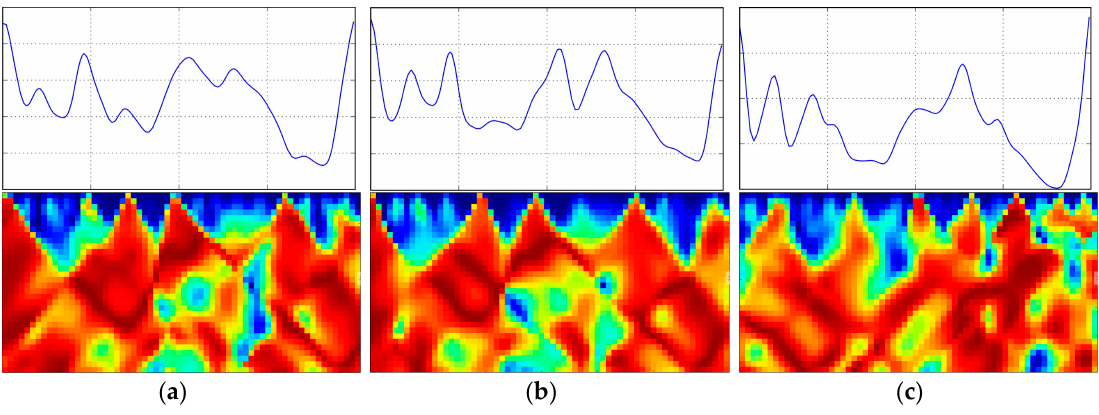
Figure 5. AE-GDIs in the second row and corresponding gait cycles in the first row, where (cid:1840) (cid:3050) = 64 , (cid:1840) (cid:3035) = 32 . ( a , b ) are from the same subject and ( c ) is from a different subject.